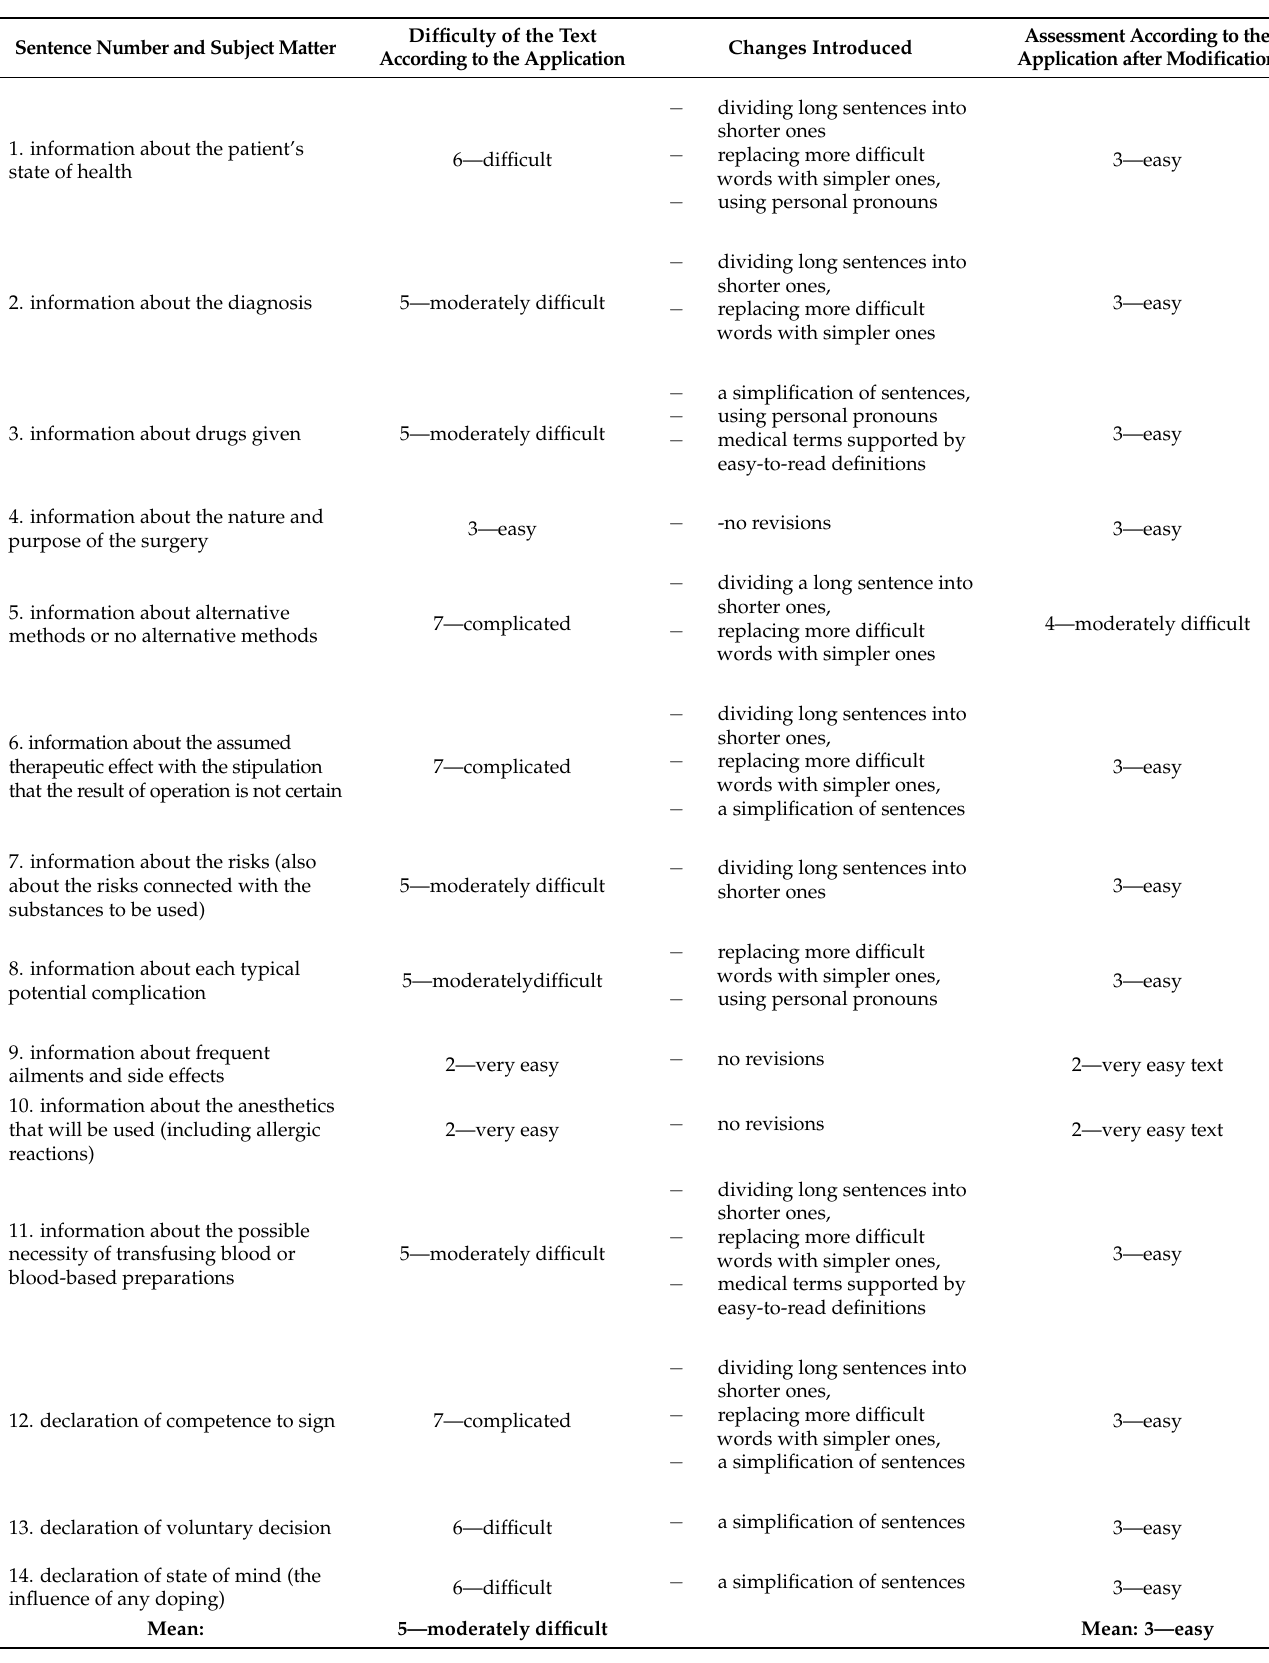
Table 1. Results of analysing the informed consent form with the Jasnopis